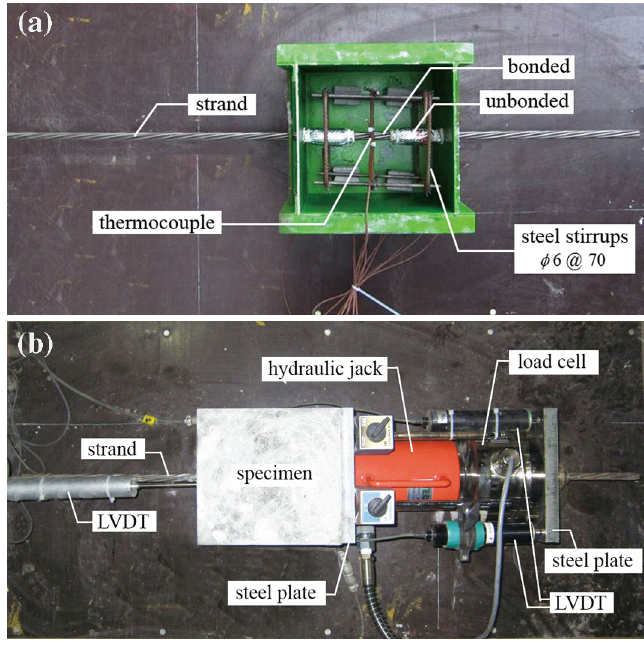
Fig. 2 Pull-out specimens and test setup. a Reinforcement of pull-out specimens and b test